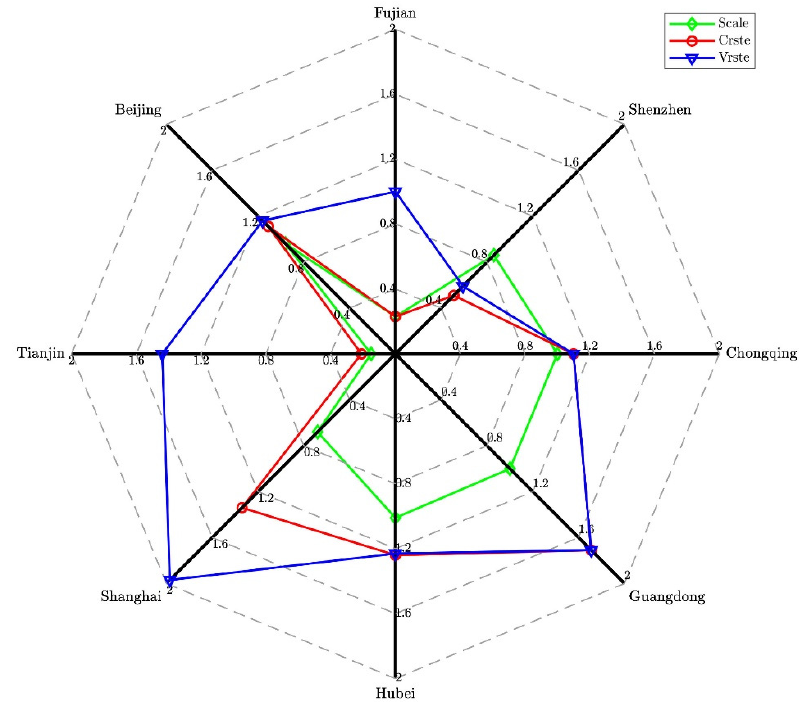
Figure 5. DEA efficiency measurement of the carbon market in 2019.